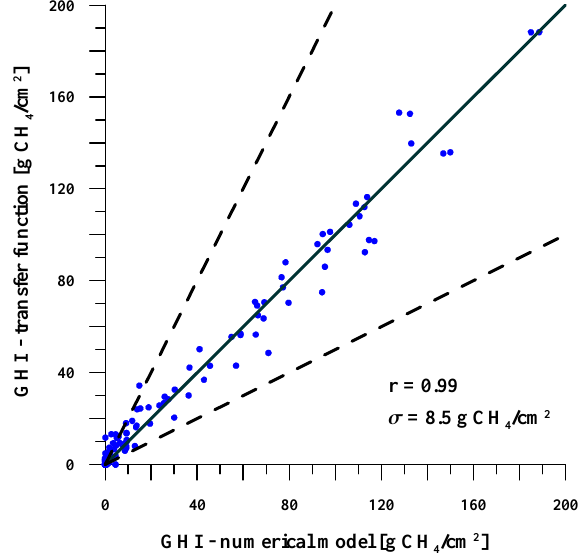
Fig. 12. Crossplot of the depth integrated GH masses estimated by the transfer function and the numerical models (sensitivity- and parameter analyses). The solid line shows the 1:1 correlation, the dotted lines the 50% deviation interval. The standard deviation σ and the correlation coefficient r are